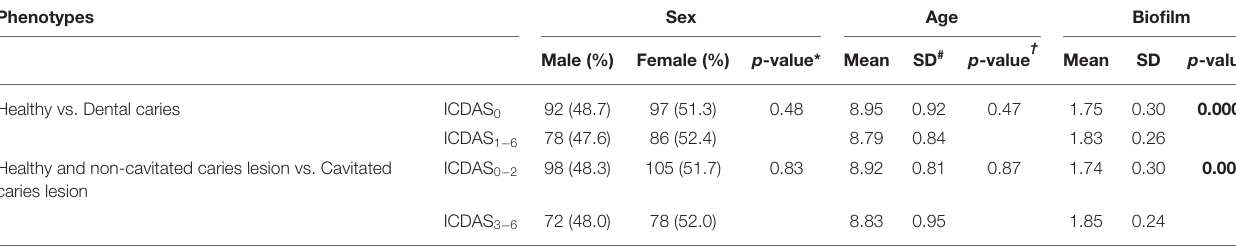
TABLE 2 | Gender, age and biofilm distribution between phenotypes. Phenotypes